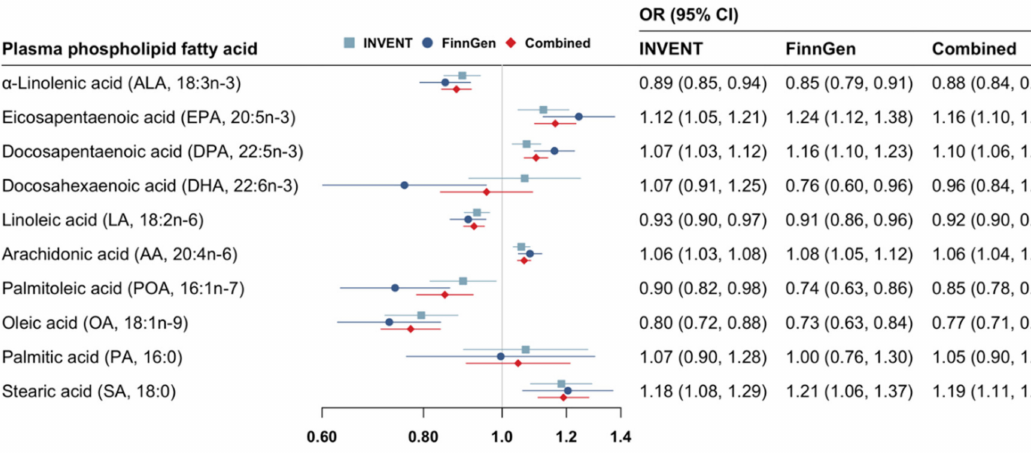
Figure 2. Associations of genetically predicted circulating levels of fatty acids with risk of venous thromboembolism. CI indicates confidence interval; INVENT, the International Network Against Venous Thrombosis; OR, odds ratio. The associations were scaled to one standard deviation increment in genetically predicted circulating levels of fatty